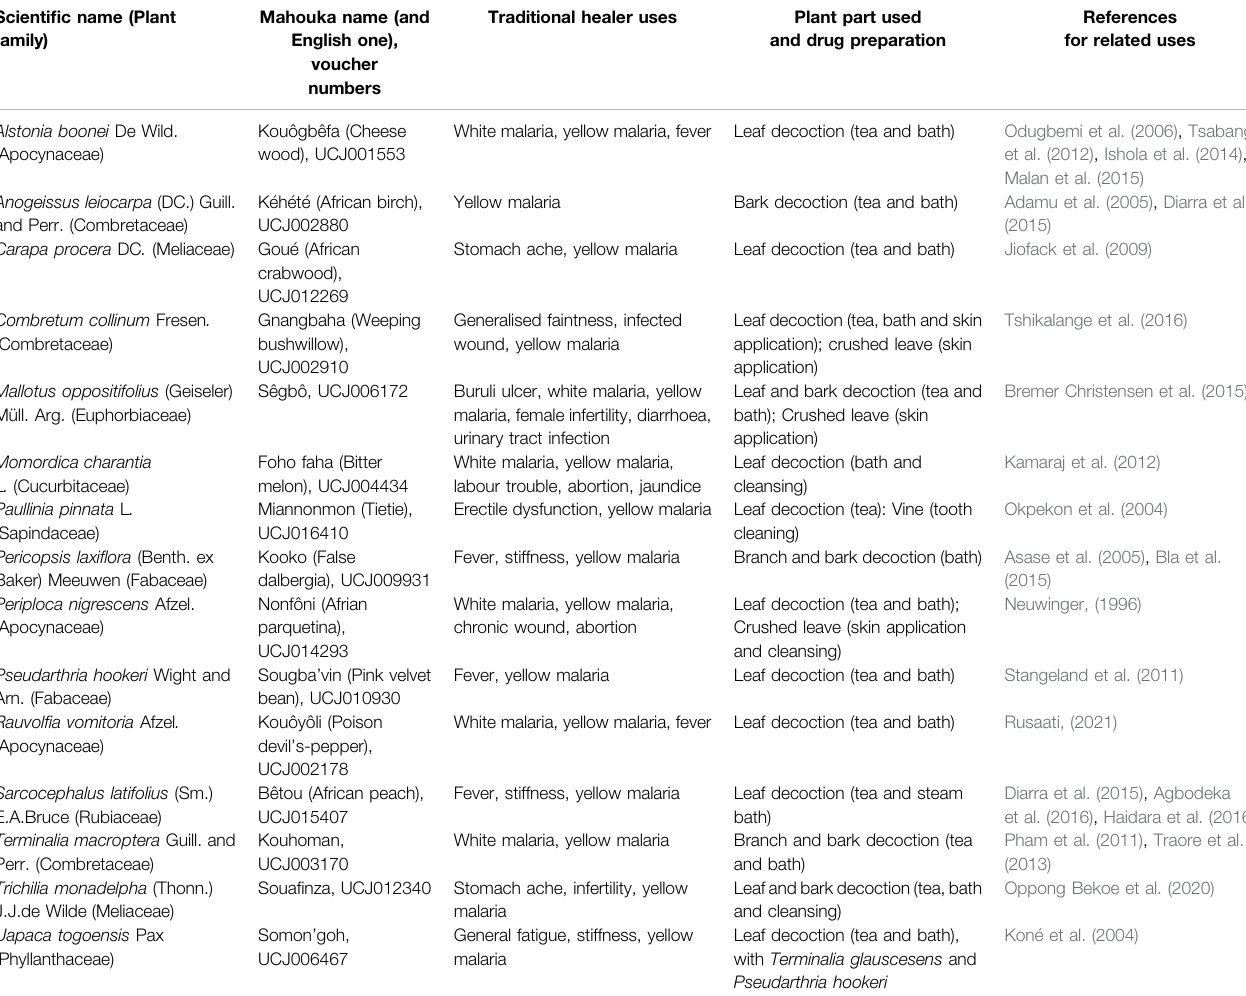
TABLE 1 | Ivorian plants traditionally used by the surveyed healers to treat yellow